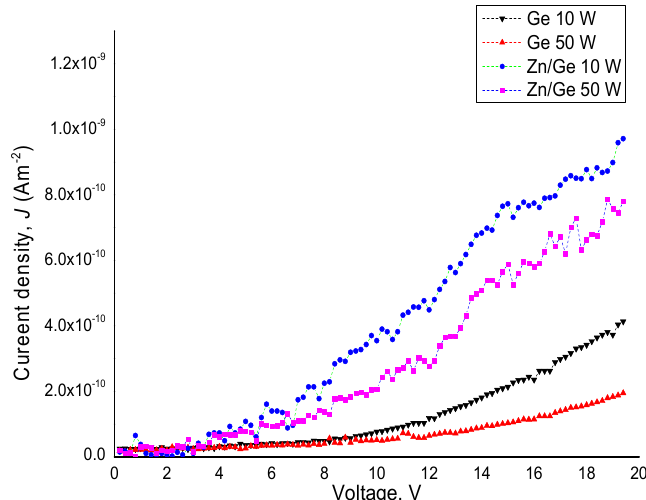
Figure 4. Density (J) of pristine and composite polymer films manufactured at 10 W and 50 W as a function of applied voltage (V).